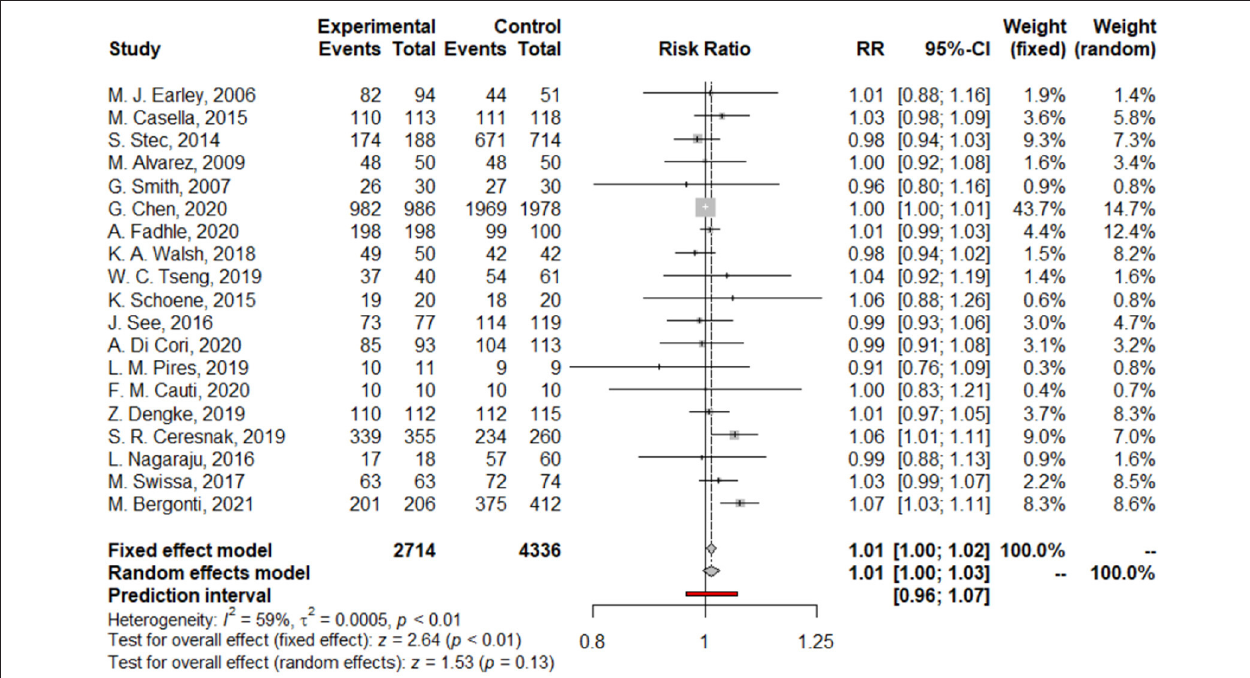
FIGURE 3 | Forest plots of long-term success rate.